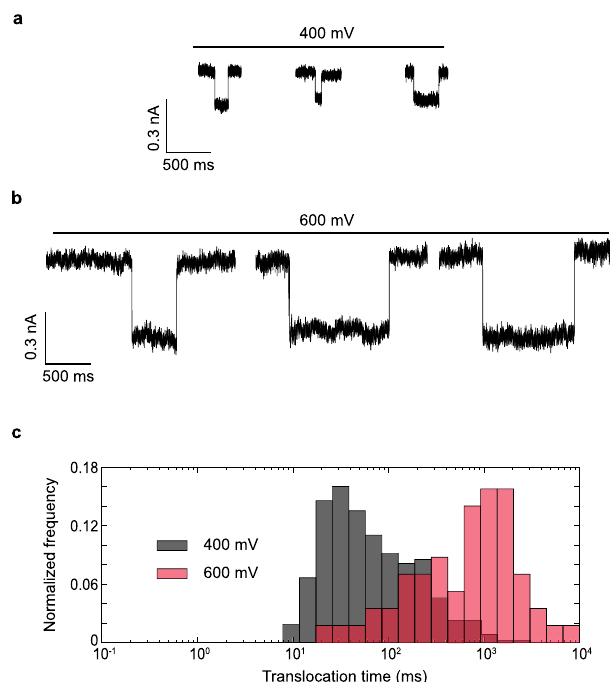
Fig. 3 Effects of electric fi eld leakage on ssDNA transport. a Representative translocation signals for 22 nt ssDNA translocations at applied voltages of 400 mV. b Representative translocation signals for 22 nt ssDNA translocations at applied voltages of 600 mV. c Normalized histogram of corresponding translocation times at applied voltages of 400 mV ( n = 480 events) and 600 mV ( n = 57 events) and average translocation time as a function of applied voltage. Increasing the strength of electric fi eld leakage can increase the translocation time of ssDNA. Data were acquired using a nanopore coated with 3 nm Al 2 O 3 fi lm (diameter, 8 nm; half cone angle, 9 ±